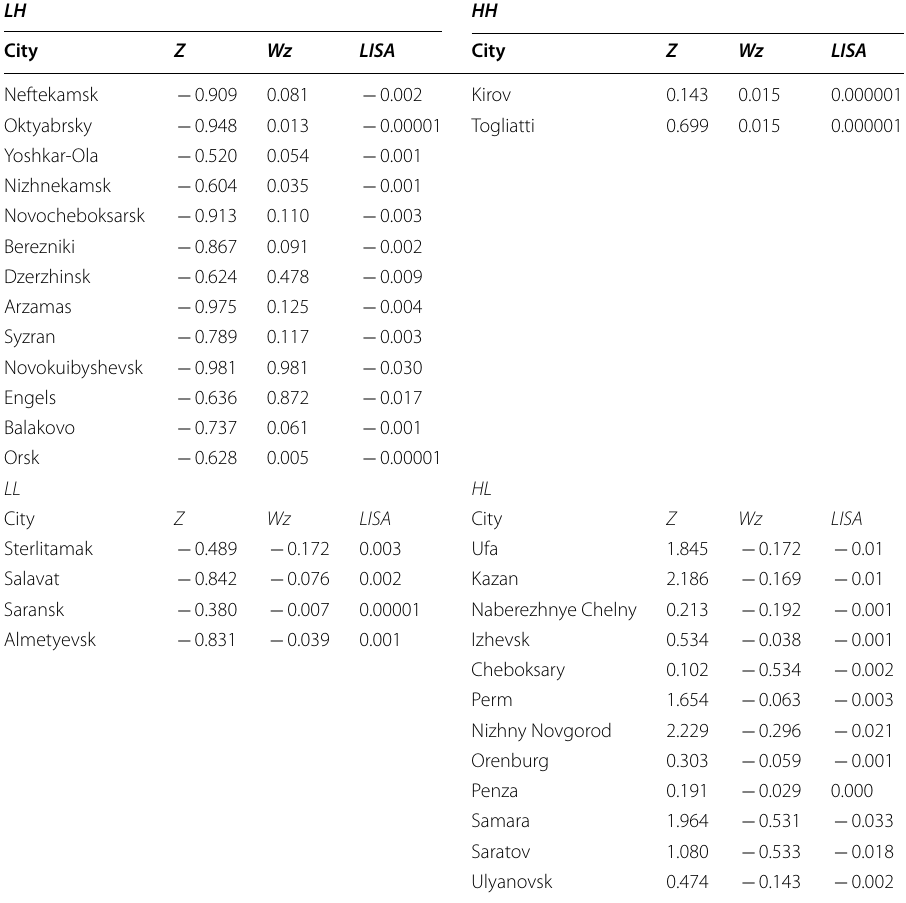
Table 2 Grouping of cities of the Volga Federal District of Russia by the Moran’s index (population size) in 2017 (Russian regions. Main social and economic parameters of cities. 2018 // Federal Service of State Statistics [Electronic resource] URL:http:// www. gks. ru/ free_ doc/ doc_ 2018/ region/ reg-